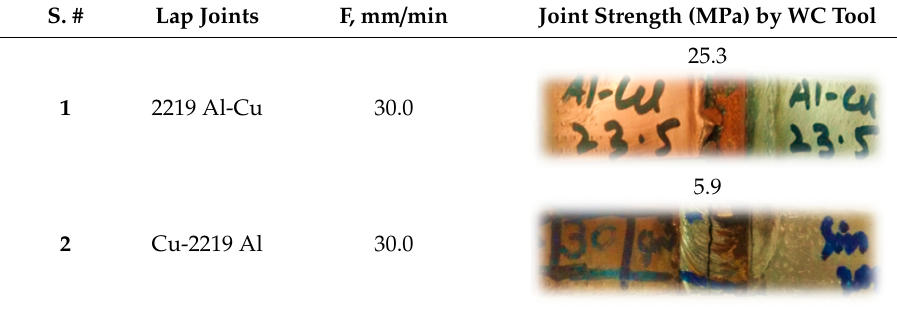
Table 11. Effect of plate position on the strength of lap joint. Table 11. E ff ect of plate position on the strength of lap joint.